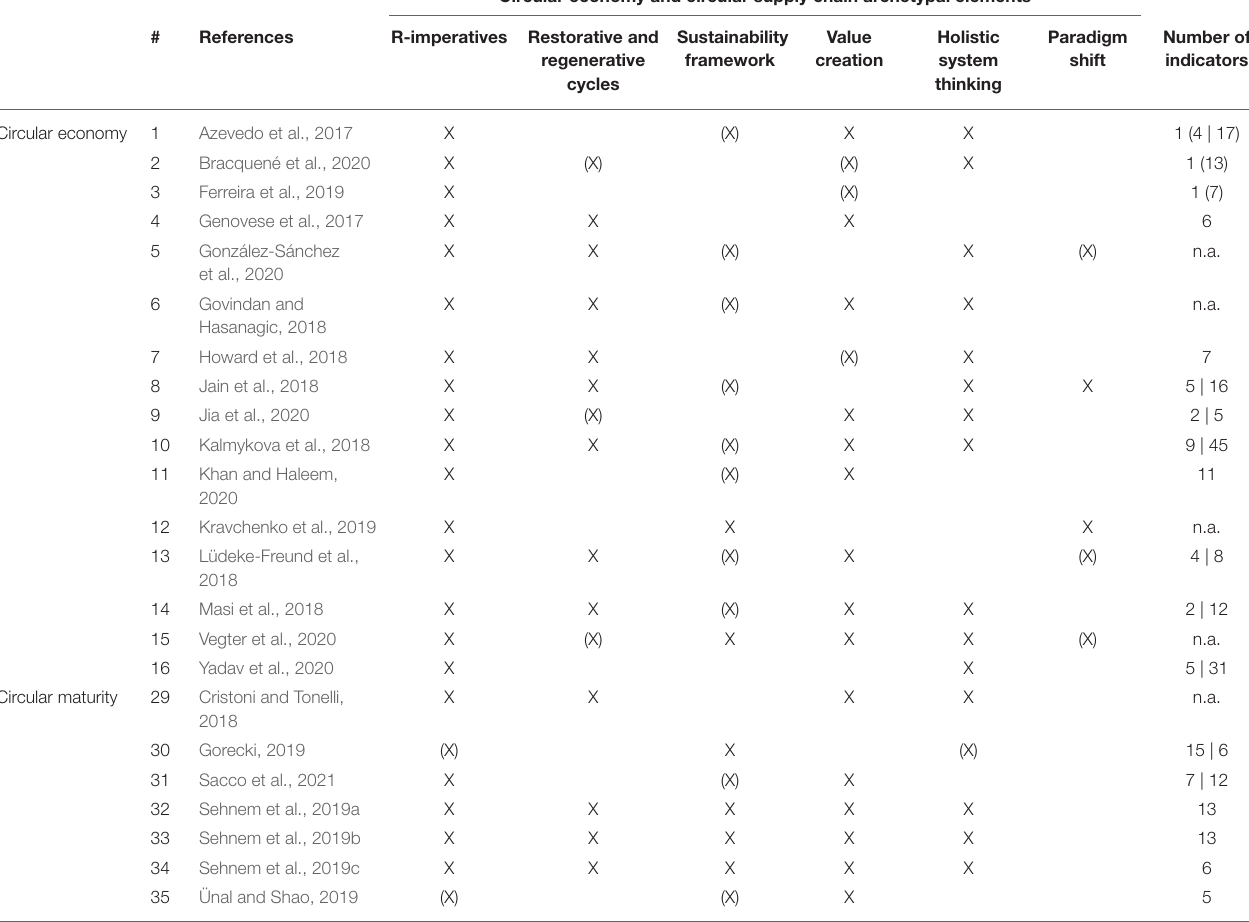
Circular economy and circular supply chain archetypal